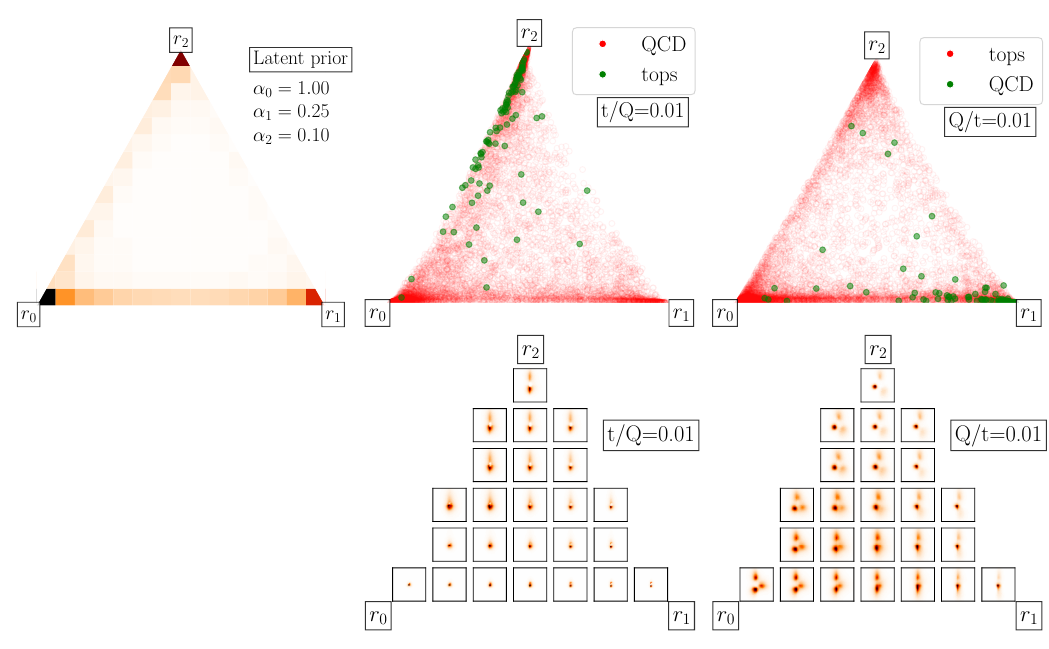
Figure 13: Gibbs triangle plots, also known as the Ternary plots or de Finetti dia- grams, for the R = 3 Dirichlet latent space. Top row: the prior distribution (left) on the latent space, and the distributions of jets for anomalous top (centre) and QCD (right). Bottom row: visualisations from the latent space of the models trained in the anomalous tops and anomalous QCD